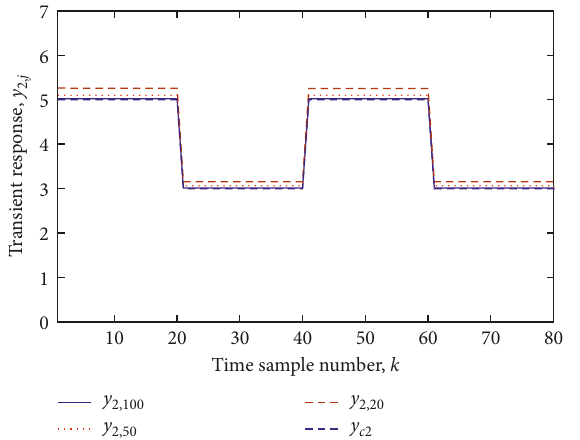
Figure 12: Tracking errors profiles of ILC e